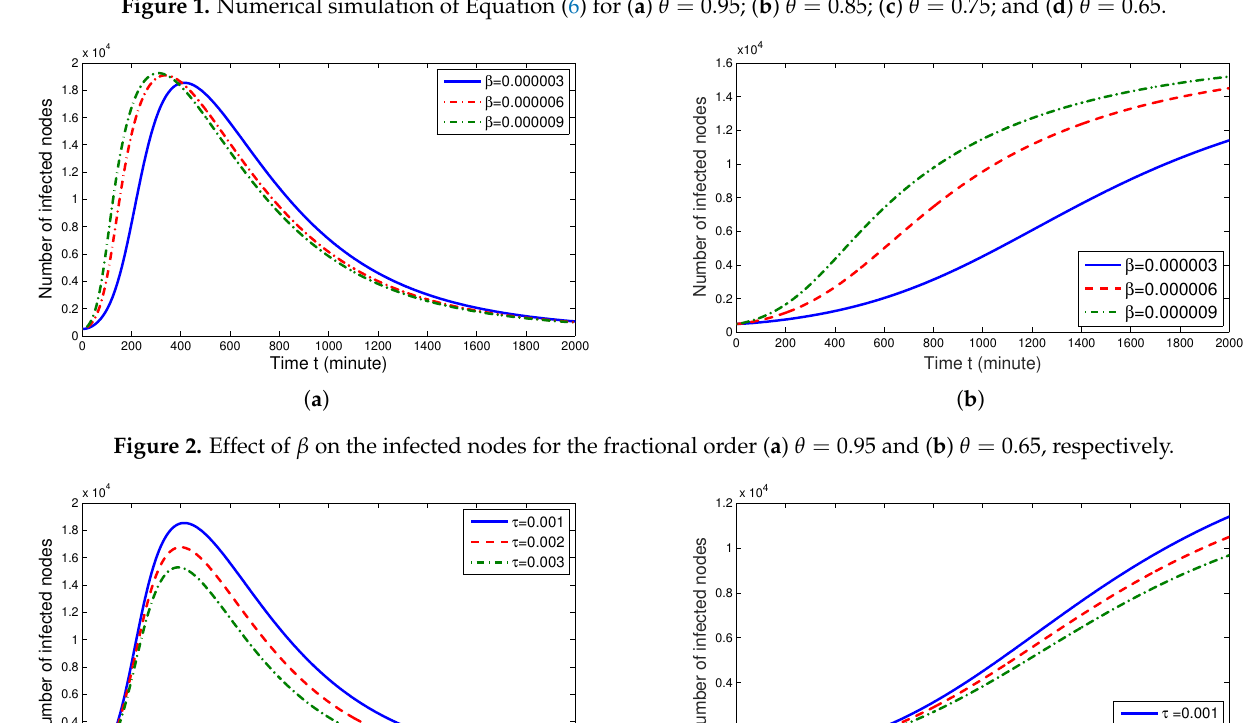
Figure 1. Numerical simulation of Equation (6) for ( a ) θ = 0.95; ( b ) θ = 0.85; ( c ) θ = 0.75; and ( d ) θ = 0.65.